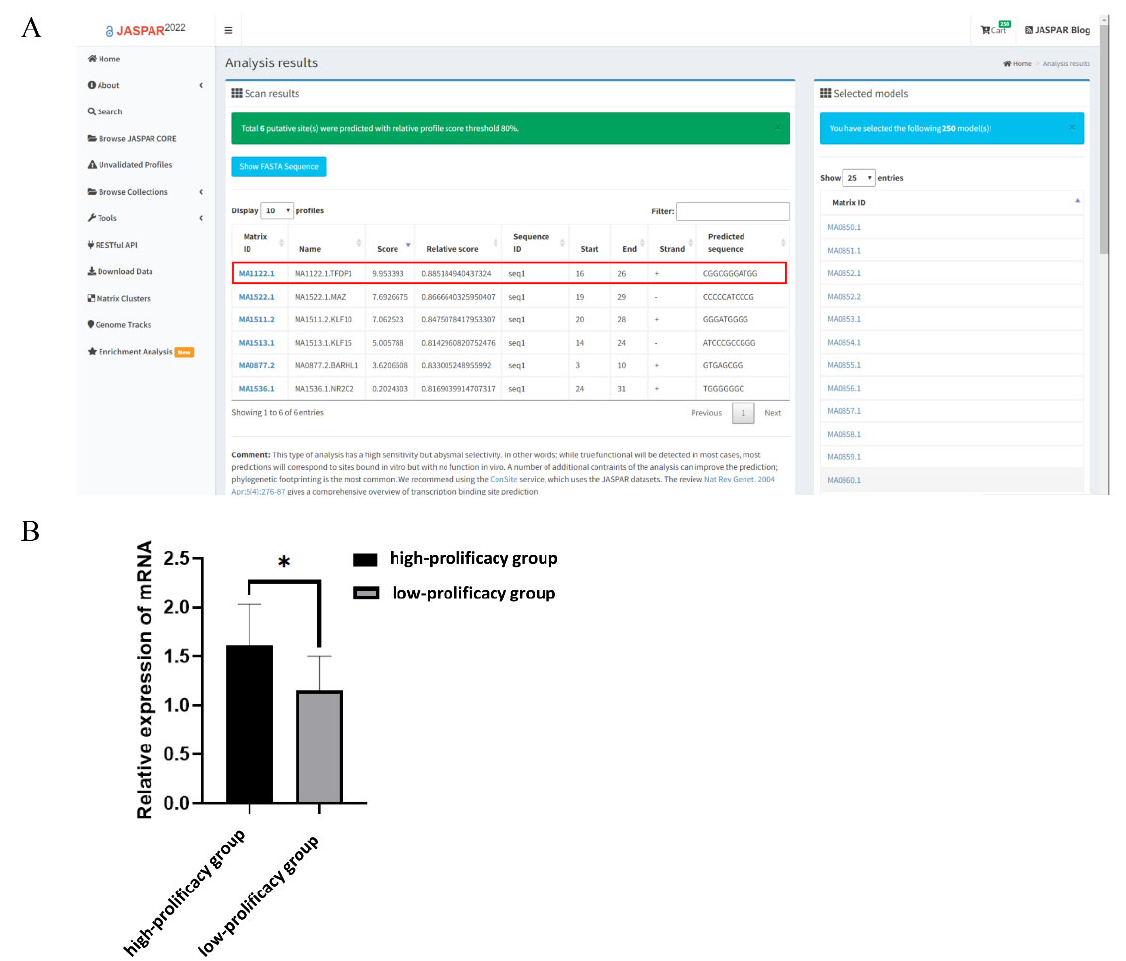
Figure 4. ( A ): RBP4 g.36491960G>C mutation binding transcription factor prediction